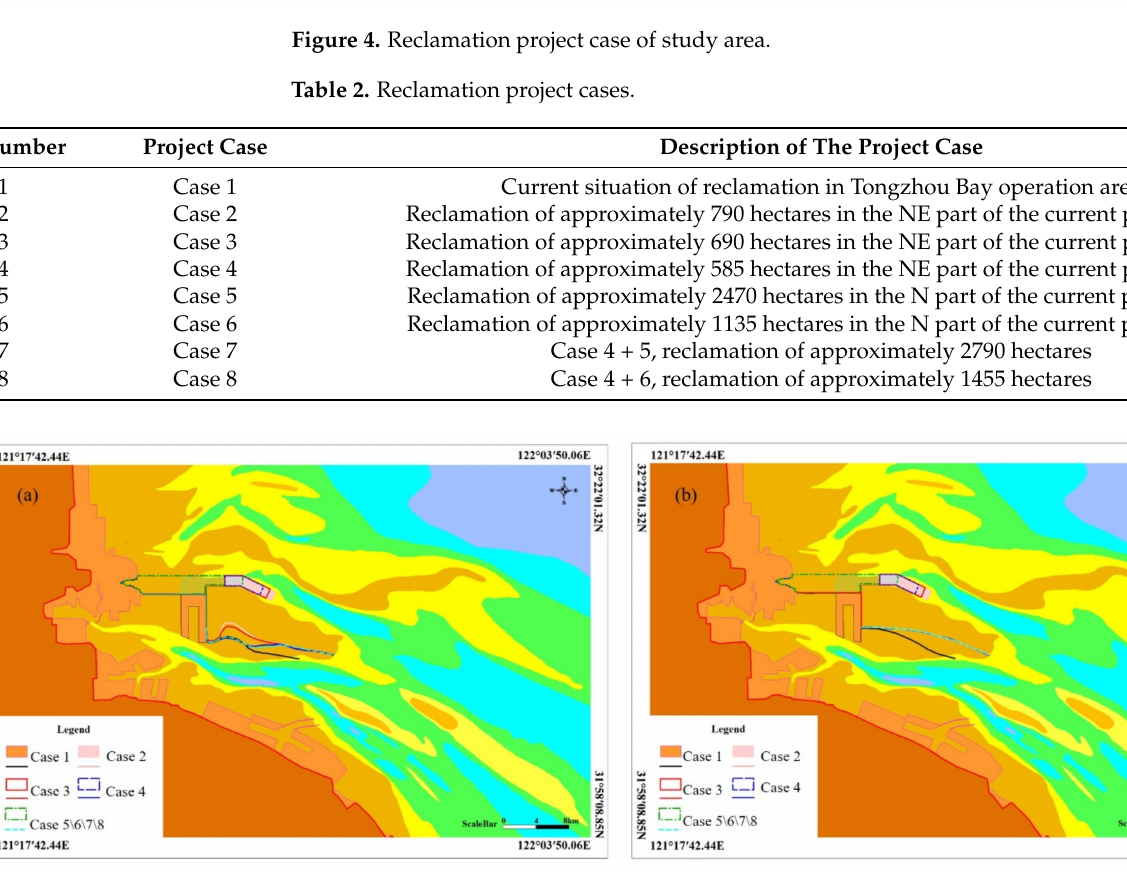
Figure 5. The change of catchment line ( a ) and dividing line ( b